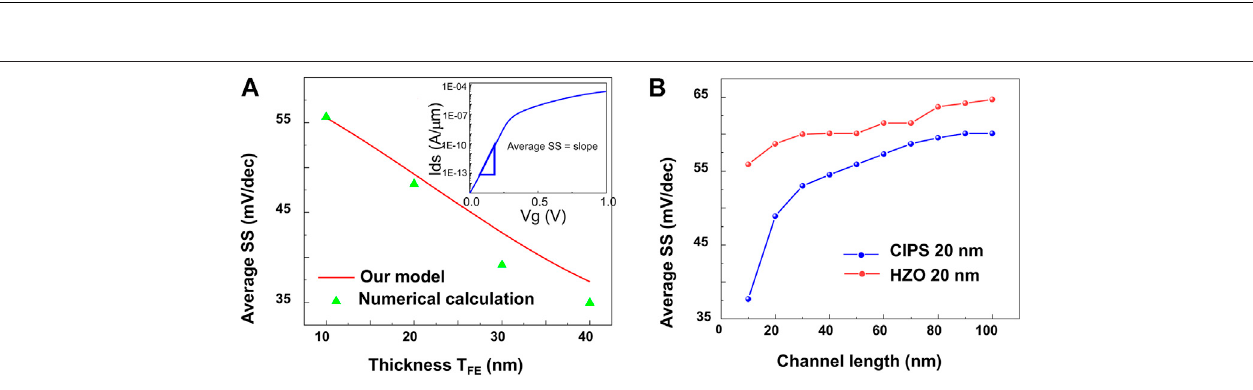
Frontiers in Materials |